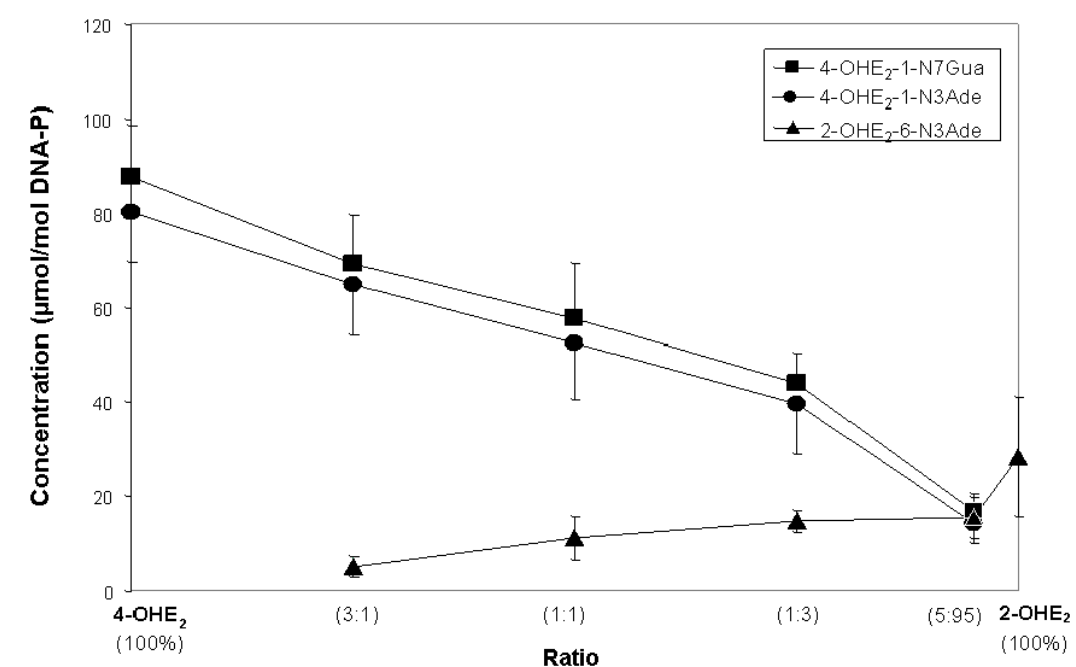
Figure 2. Depurinating adducts formed after 10 h (to allow complete depurination of 4-OHE 2 -1-N7Gua) by mixtures of lactoperoxidase-activated 4-OHE 2 and 2-OHE 2 reacted with DNA at different ratios. The level of stable adducts formed in the mixtures was less than 1% of the total adducts [37].